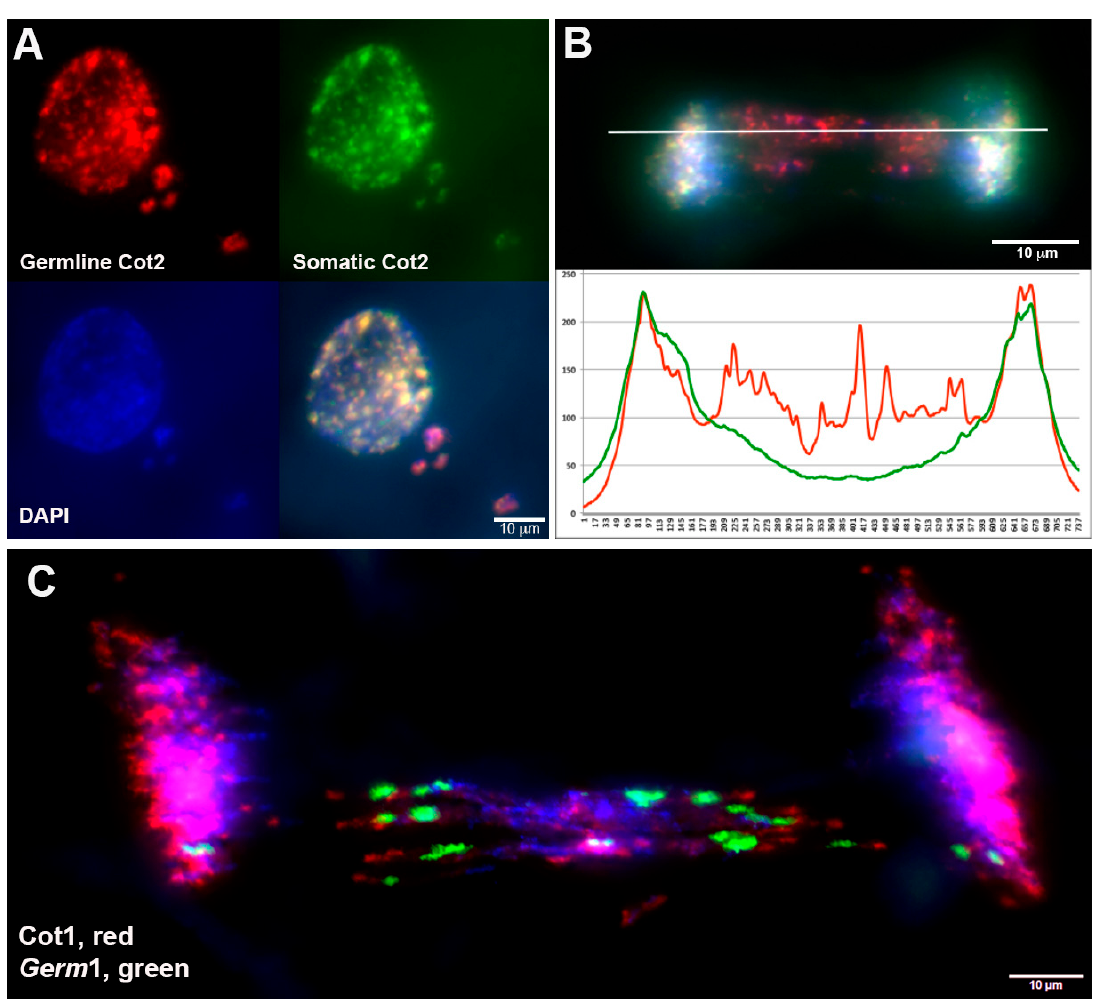
Figure 1. Repetitive DNA in situ hybridization in eliminating cells of 1.5 dpf sea lamprey embryos. ( A ) An example of competitive hybridization repetitive DNA fraction from testes (red) and liver (green) in a cell containing micronuclei. ( B ) Hybridization of C 0 t2 DNA-probes from germline (red) and somatic (green) to a lagging anaphase and a corresponding fluorescence intensity profile (measurement plane is marked by a horizontal line). ( C ) Hybridization of C 0 t1 (red) and Germ 1 (green) to a lagging anaphase.